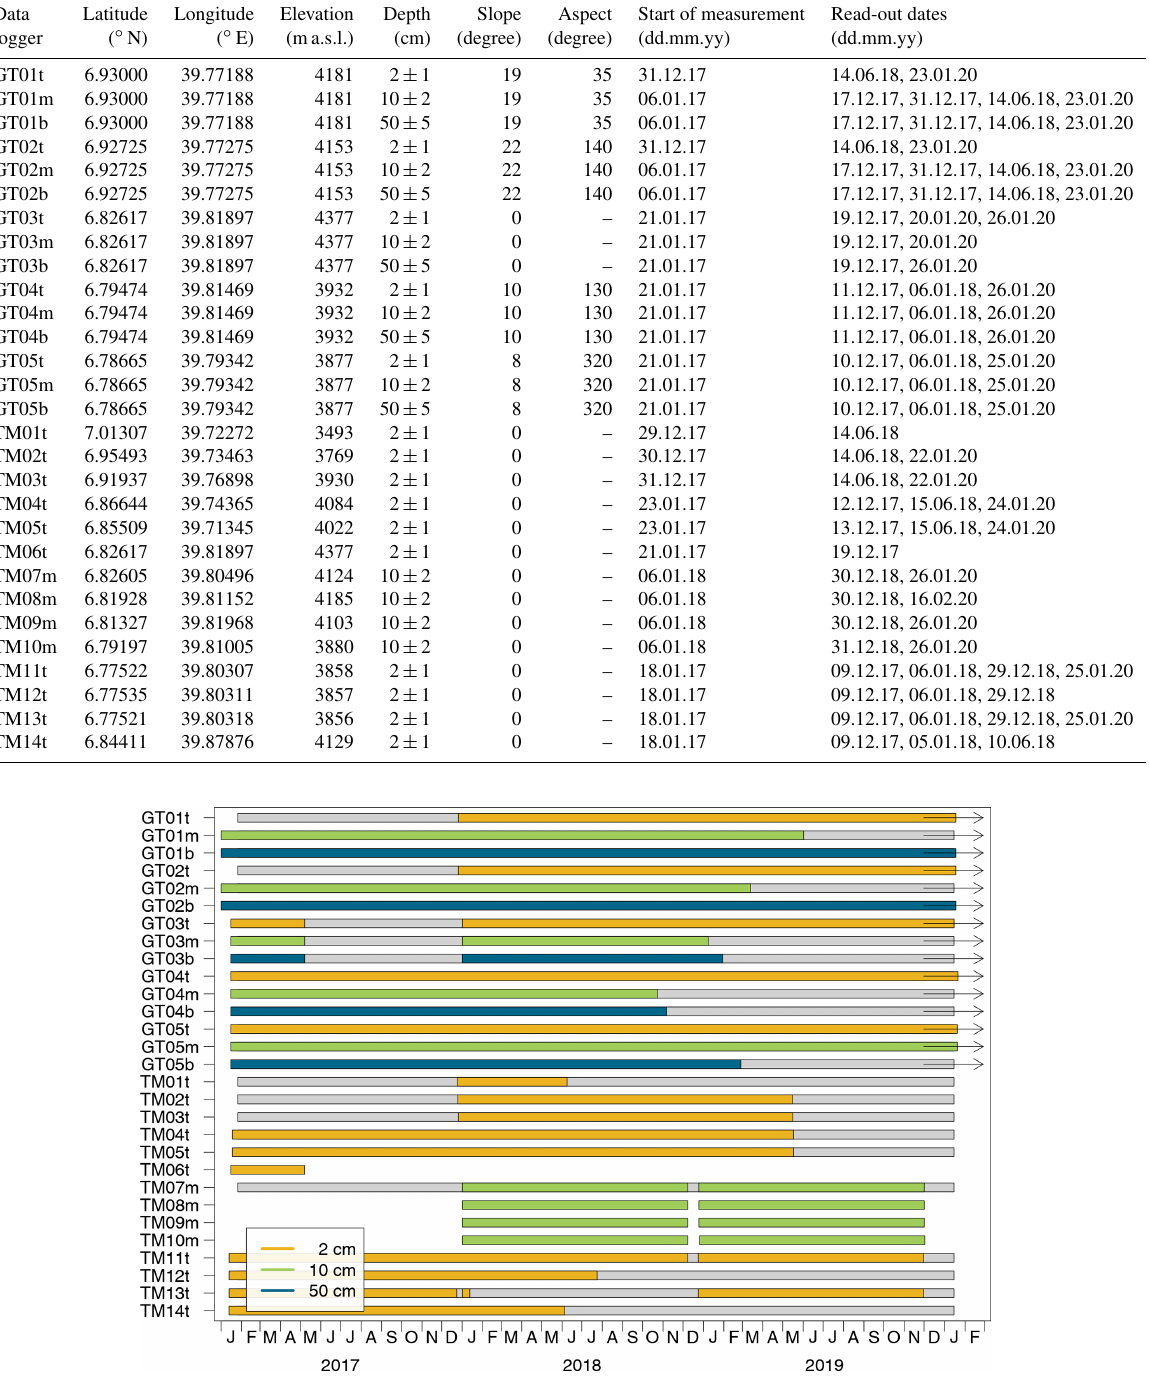
Earth Syst. Sci. Data, 14, 1043–1062,